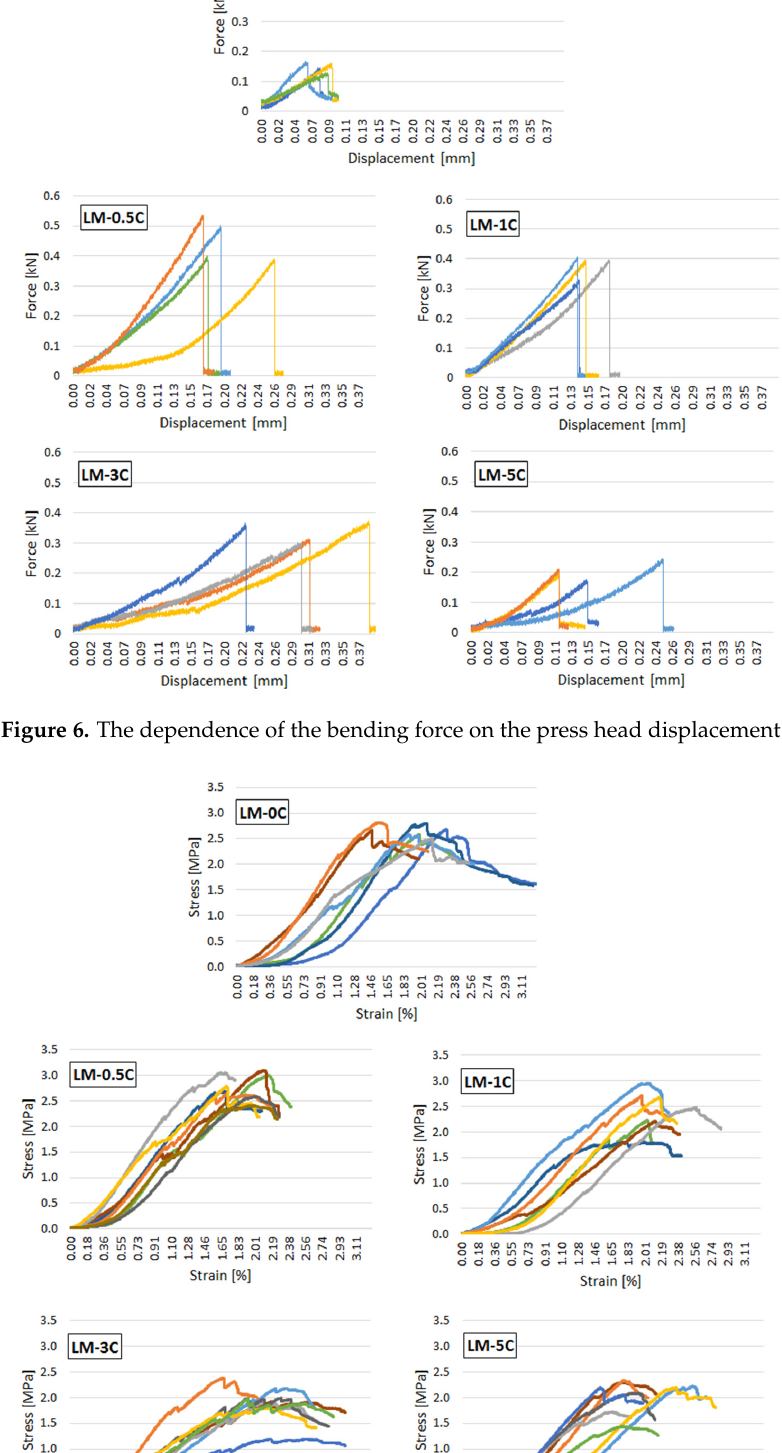
Figure 8. Average values of flexural strength ( left ) and compressive strength ( right ) of the tested samples (error bars mean standard deviation). Figure 9 shows the effect of carbonation progress on sample breakthroughs after the phenolphthalein test.